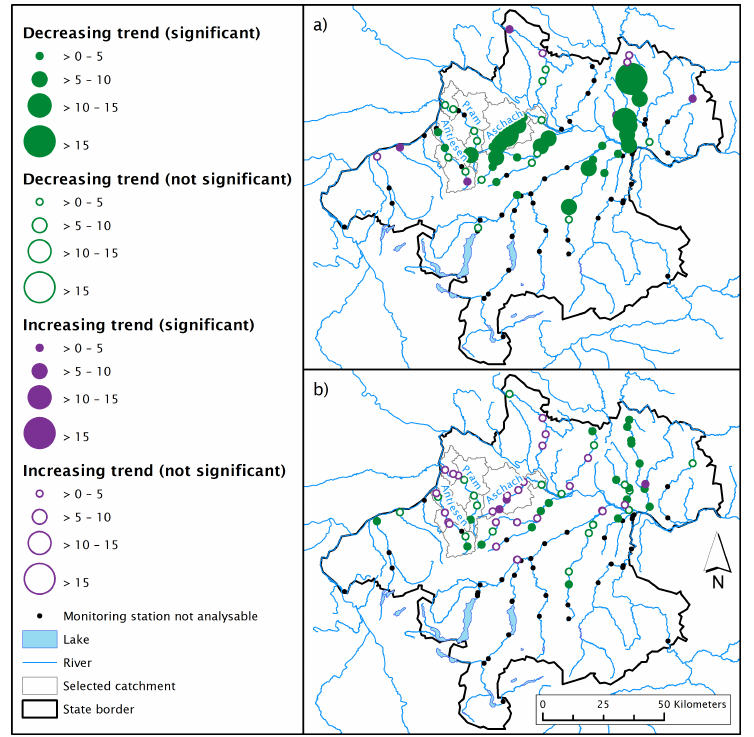
Figure 2. Trends of soluble reactive phosphorus concentration (µg SRP L − 1 year − 1 ) in surface waters in Upper Austria for the following two periods: ( a ) 1990–2000; ( b )